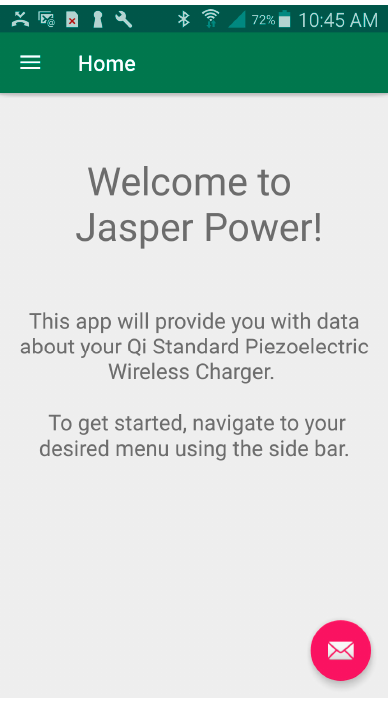
Figure 14. Jasper Power Custom Application.